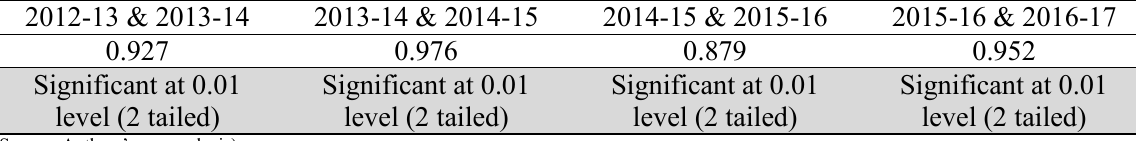
Correlation between year to year financial performance based ranks